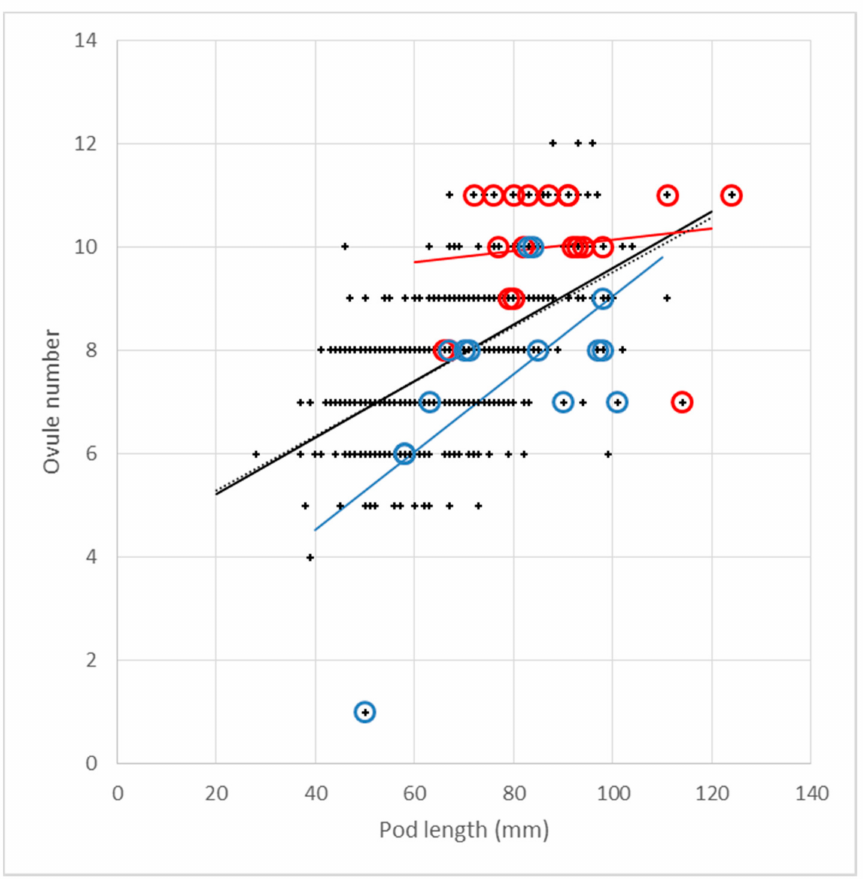
Figure A1. Pod length vs. ovule number: Data are plotted (+) for 594 accessions grown in 2020 (Supplementary Table S1). Data for the 20 accessions with unusually long and narrow pods are ringed in red, and the 15 accessions identified with unusually short and wide pods are ringed in blue. Linear regressions are plotted for all data (solid black line), the unusually long and wide pods (solid red line), unusually short and wide pods (solid blue line) and all data excluding the unusual pods (dotted black line). The regression lines are y = (4.1 ± 0.21) + (0.05 ± 0.003) x , r 2 = 0.33, n = 594; y = (9.0 ± 1.66) + (0.01 ± 0.01) x , r 2 = 0.02, n = 20; y = (1.5 ± 2.25) + (0.08 ± 0.03) x , r 2 = 0.35, n =15 and y = (4.2 ± 0.22) + (0.05 ± 0.003) x , r 2 = 0.32, n = 559 respectively. The three accessions with 12 ovules per pod are JI0582, JI2016 and